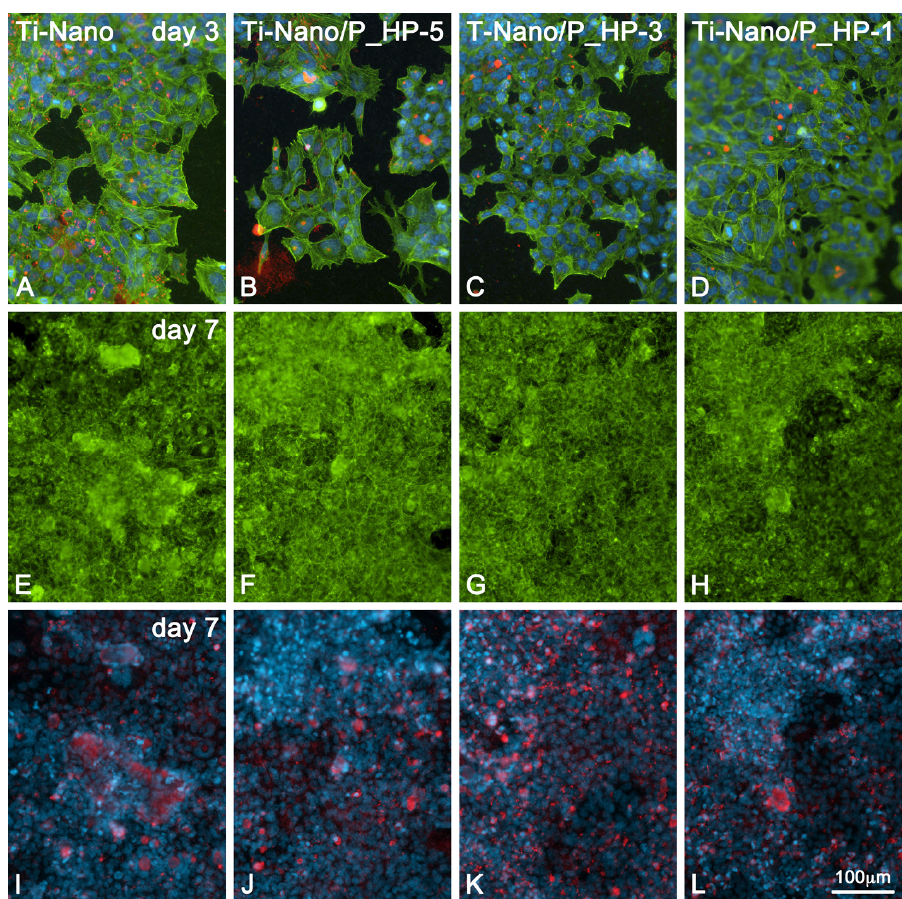
Figure 5. Epifluorescence of UMR-106 cells grown on Ti-Nano surfaces functionalized with 1 × 10 − 5 , 1 × 10 − 3 , and 1 mg/mL grape-pomace extract and the control surface on days 3 ( A – D ) and 7 ( E – L ) of culture. (Ti-Nano, Ti-Nano/P_HP-5, Ti-Nano/P_HP-3, and Ti-Nano/P_HP1) Green, red, and blue fluorescence depicts actin cytoskeleton, bone sialoprotein (BSP), and cell nuclei, respectively. Note the BSP-positive mineralized matrix foci in ( I – L ). The microscopic fields are the same respectively for ( E - I , F - J , G - K , H - L ).